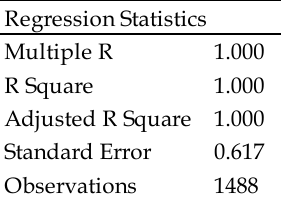
Table 3. Results of the second regression model for defining the capacity